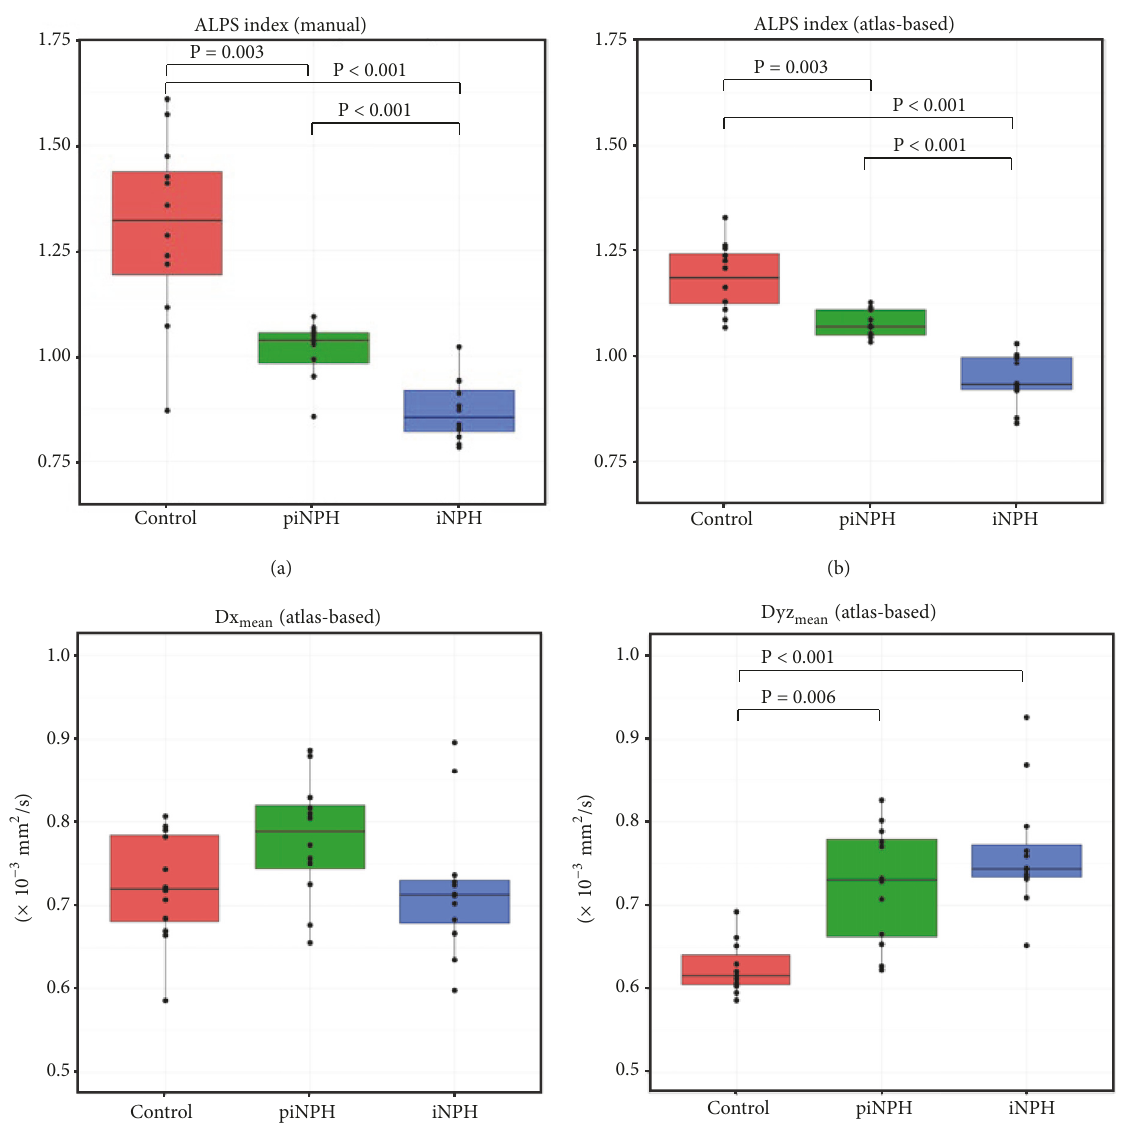
Figure 4: Box-plots of ALPS indexes with the manual (a) and with the atlas-based (b) methods and Dx mean (c) and Dyz mean (d). Only significant P values were shown in the figures. All the values were described in Table